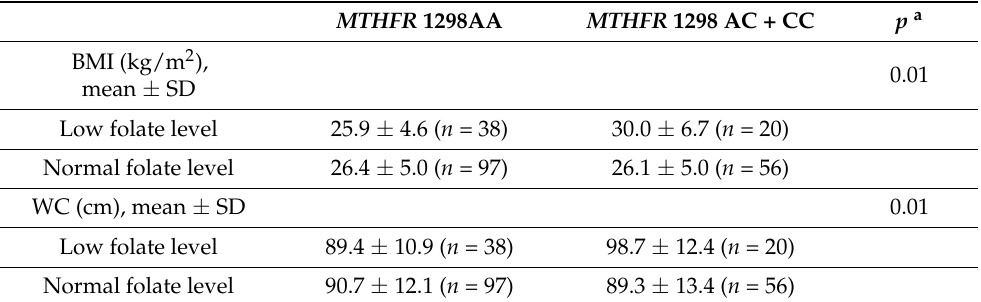
Table 4. Interactions between MTHFR A1298C and folate levels in terms of body mass index and waist circumference in patients with